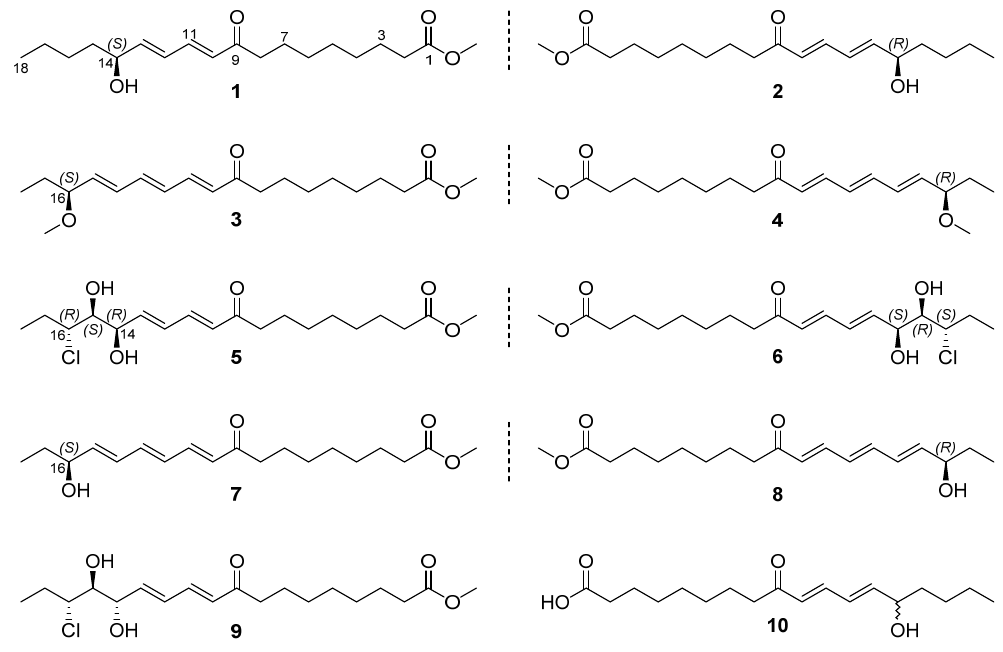
Figure 1. Chemical structures of 1 – 10 from Plantago depressa.